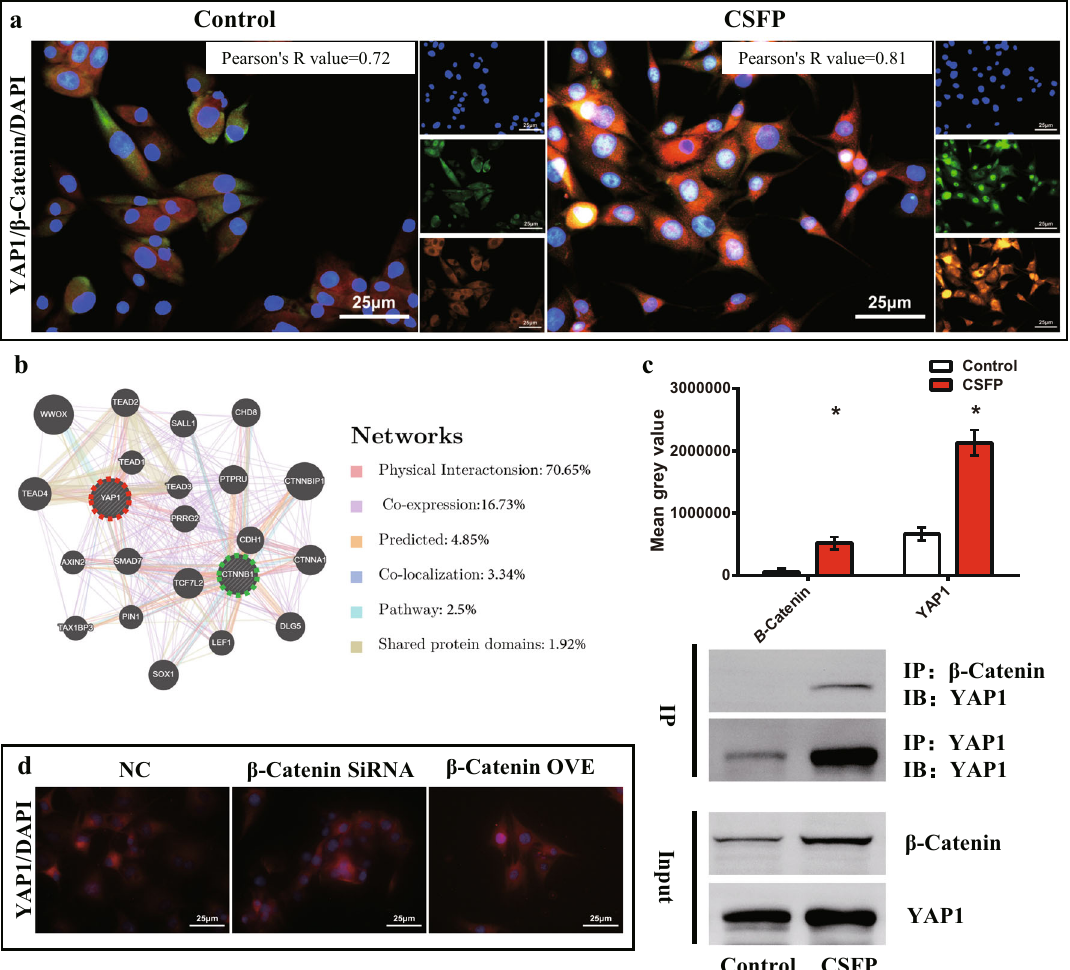
Fig. 8 CSFP promoted the binding of β -Catenin and YAP1. a Double immuno fl uorescent staining revealed colocalization of β -Catenin (Red) and YAP1 (Green). b GeneMANIA database showed the probability of physical interactions between β -Catenin and YAP1 was 70.65%. c Co-IP analysis showed that CSFP promoted the binding of β -Catenin and YAP1. d Overexpression or knockdown of β -Catenin did not affect the activities of YAP1. Data are presented as mean ± SEM, and * P <